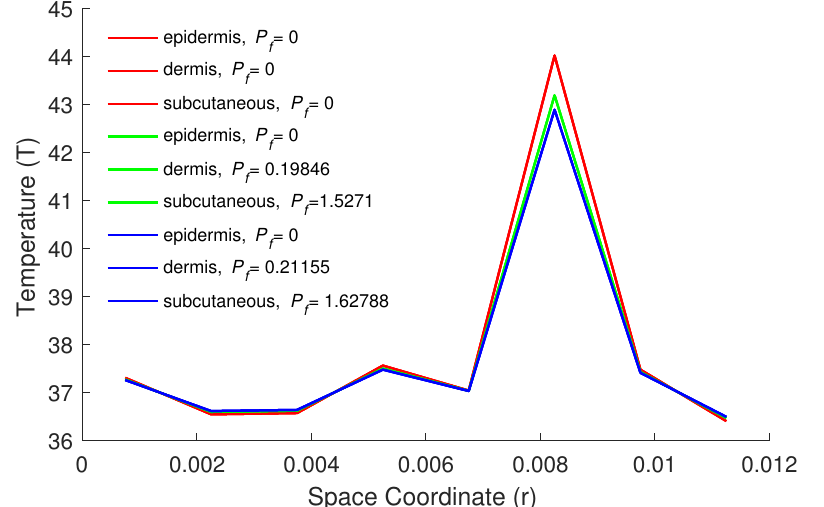
Figure 7. Temperature distributions for different values of P f in first kind